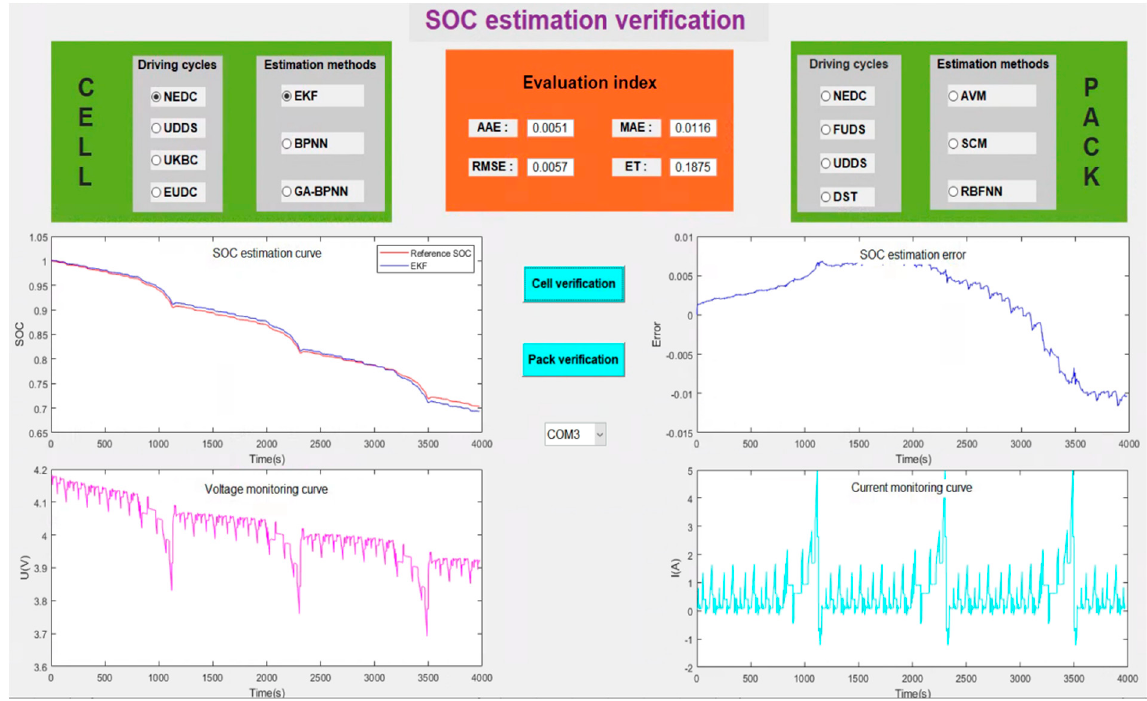
Figure 13. Verification results of the real-time SOC estimation.